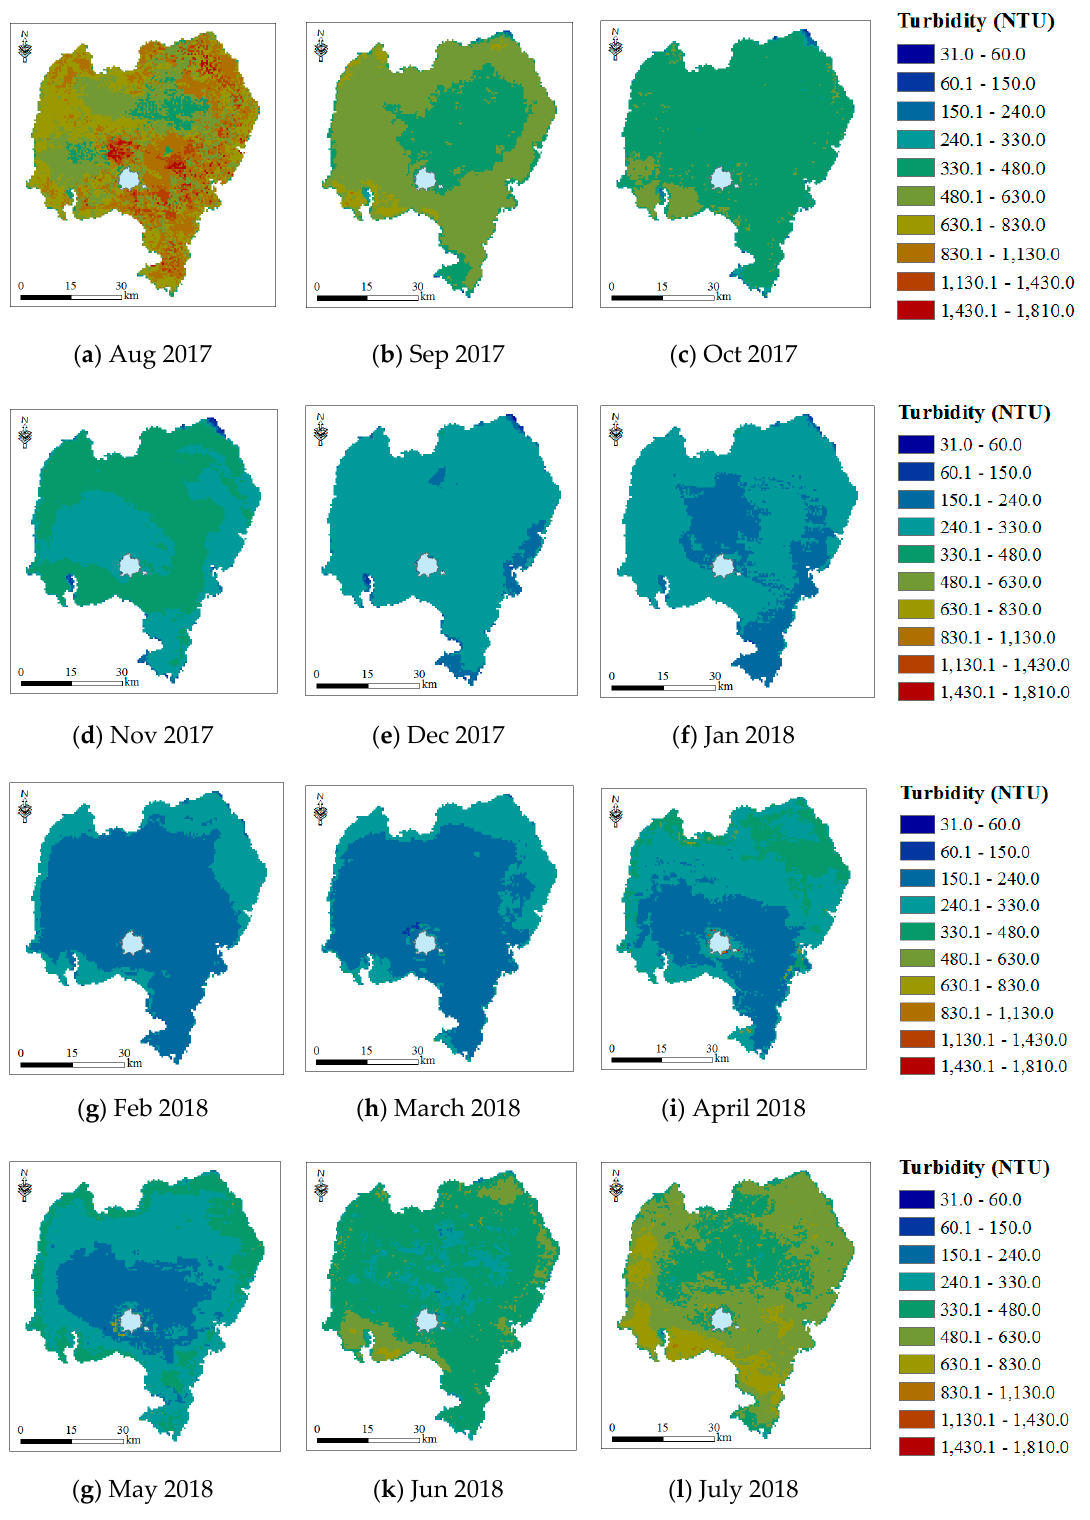
Figure 12. Spatial and temporal distribution of average monthly turbidity for the study period